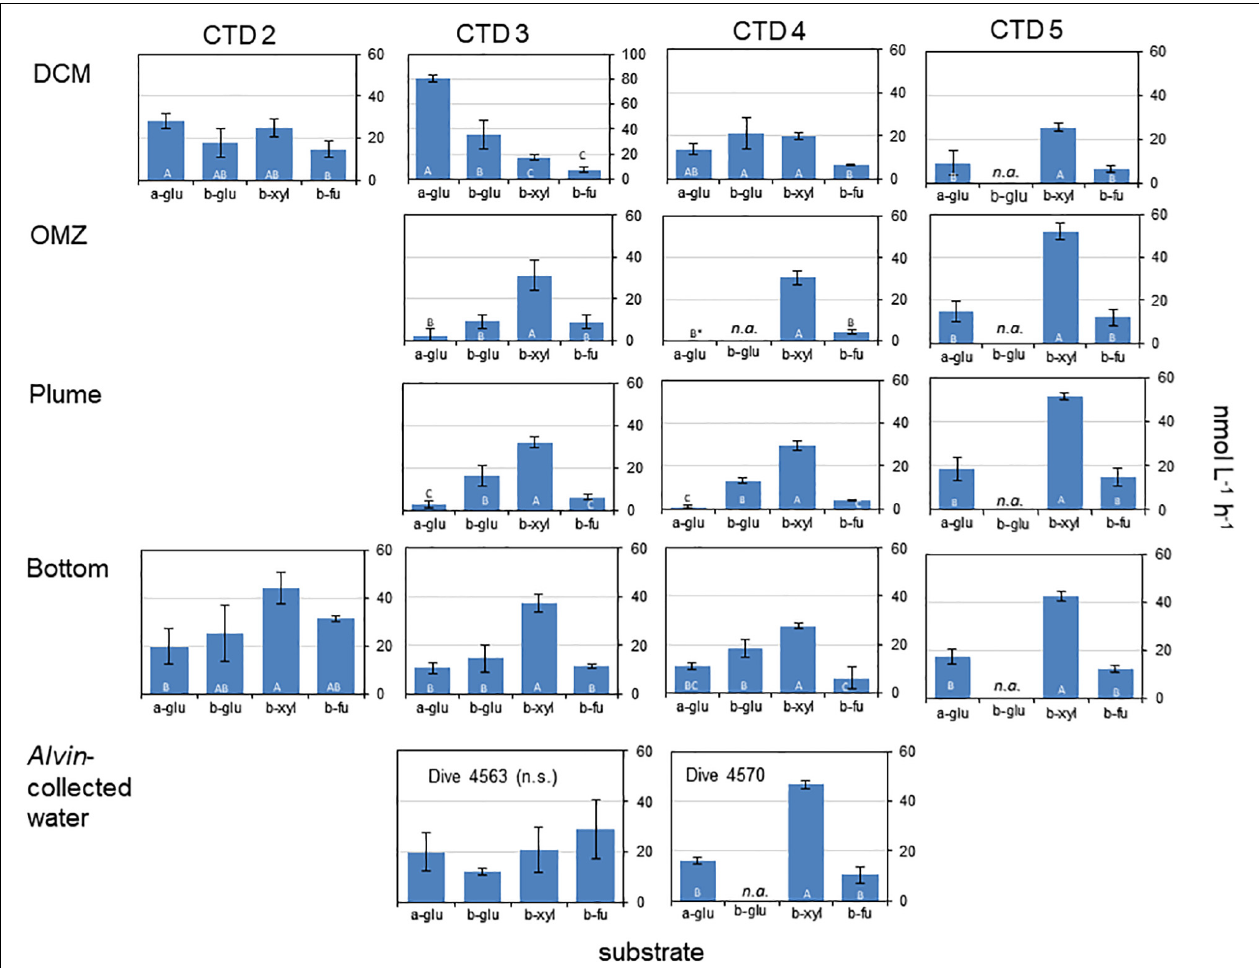
FIGURE 1 | Activities of exo-acting enzymes in water taken from CTD casts 2 – 5 and in water taken with HOV Alvin . a-glu - 4-MUF α - D -glucopyranoside; b-glu - 4-MUF β - D -glucopyranoside; b-xyl - 4-MUF ß-D-xylopyranoside; b- fu - 4-MUF ß-D-fucoside. DCM, Deep chlorophyll maximum; OMZ, Oxygen minimum zone; Bottom, Bottom water; Plume, Turbidity plume near the bottom (see Table 1 for water depths and temperatures). Hydrolysis rates are average rates of n = 3 ± standard deviation. Letters indicate results of the post hoc analysis of treatment-specific differences in rates (one-way ANOVAs, p < 0.05); rates with the same letters are indistinguishable from one another. n.a. means not available; ∗ means that a-glu activity was